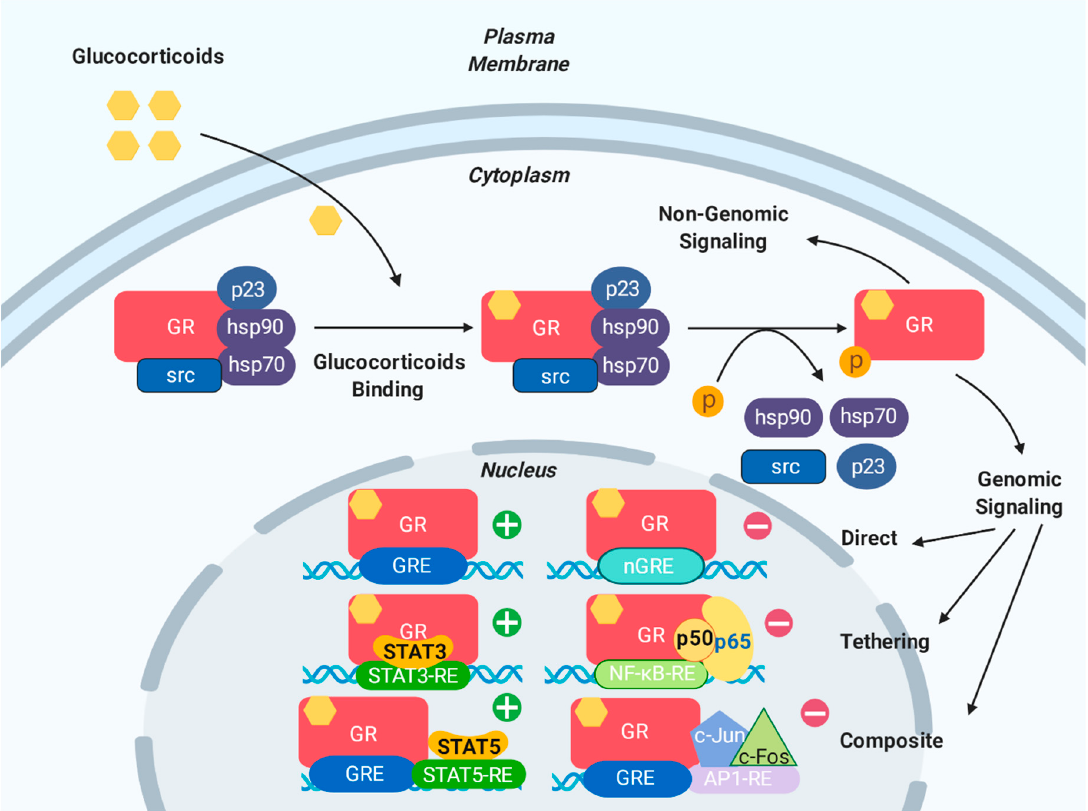
Figure 2. GR signaling pathway. Glucocorticoids bind to GR via both genomic and non-genomic signaling pathways. Once inside the nucleus, GR can function in three ways, all of which can activate or repress gene expression.